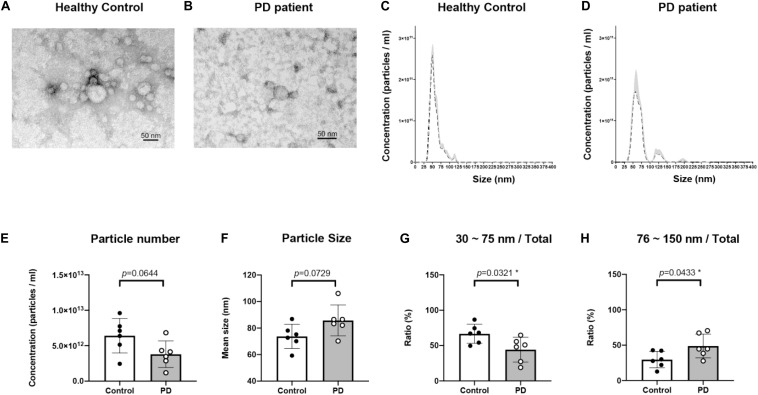
Characterization of blood neuron-derived extracellular vesicles from healthy controls and Parkinson’s disease (PD) patients. The particle size distribution of plasma extracellular vesicles from both healthy control and PD patients’ was analyzed by electron microscopy (A,B) and NTA (data are presented as mean ± SEM) (C,D). The (E) concentration and (F) average size of EVs from healthy controls and PD patients were not different. The percentages of EVs of sizes (G) 30–75 nm and (H) 75–150 nm varied in PD patients *p < 0.05.